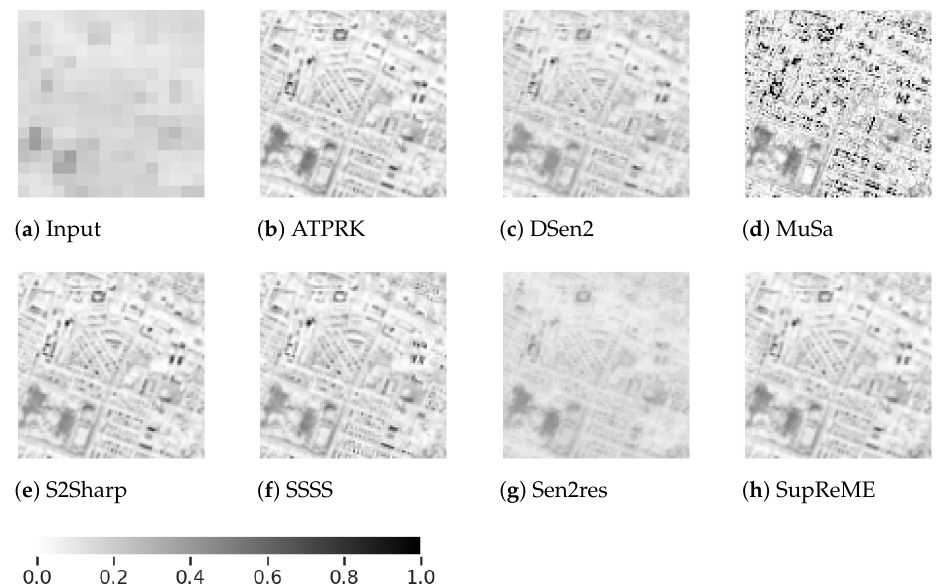
Figure 4. Band B9 of real S2 image of Reykjavik super-resolved to 10m resolution.